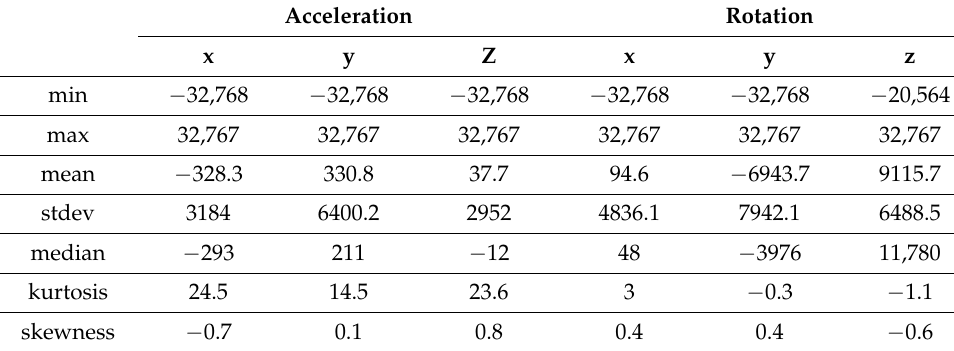
Table 1. Attributes and dataset statistics used in our study.